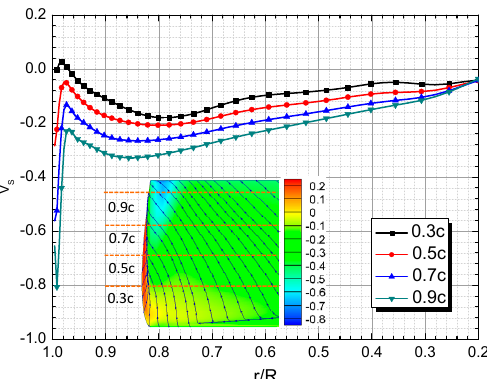
Figure 15. Spanwise velocities at different chord positions.